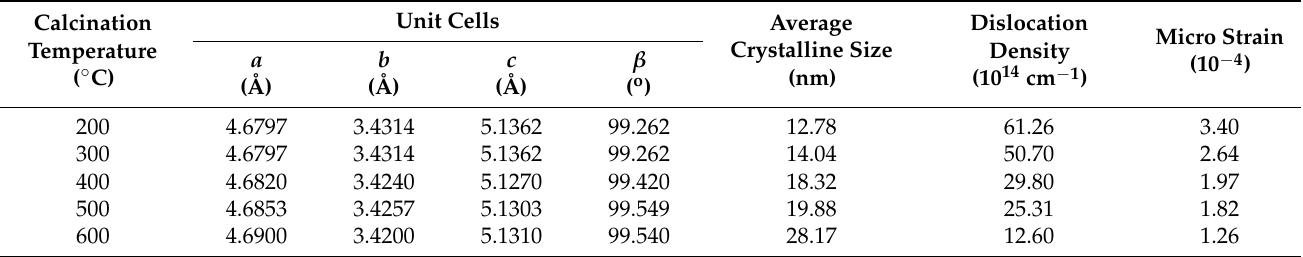
Table 3. Unit cells, crystalline size, dislocation density and micro strain of G. mangostana L. leaf extract-mediated synthesized CuO calcinated at different